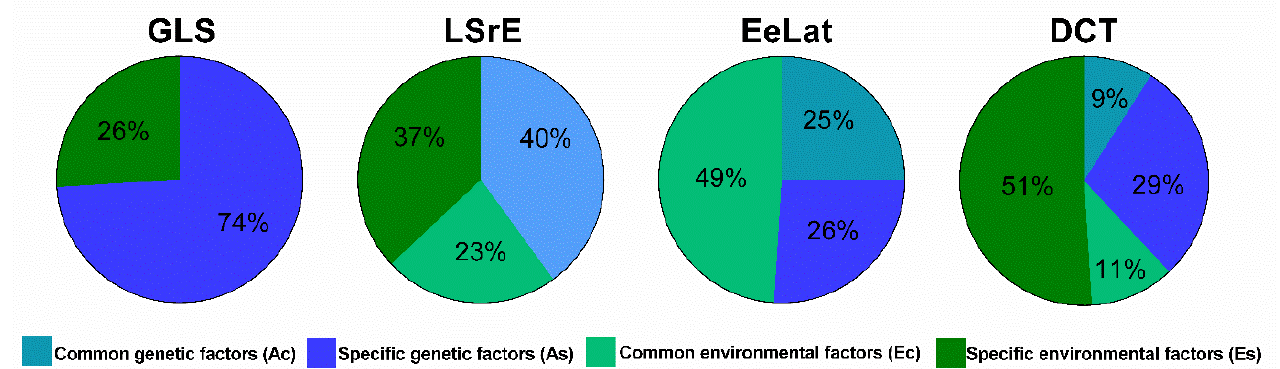
Figure 1. Schematic illustration of genetic and environmental influence on LV systolic and diastolic function using Systolo-Diastolic Model. Blue represents genetic influence, green environmental influence, the lighter shadow of each color represents specific effect, while the darker shadow the common effect. The sensitive left ventricular systolic parameter of global longitudinal strain (GLS) is mainly affected by specific genetic determinants (light blue) independent of diastolic parameters: LSrE (early diastolic strain rate), EeLat (lateral mitral annulus early diastolic tissue velocity), DCT (deceleration time of E wave). Although diastolic parameters are affected mainly by environment (all green shadows), LSrE and EeLat showed moderate genetic influence as well, proving a common effect only (dark blue) in the case of LSrE. All investigated diastolic parameters had common environmental influence (dark green).